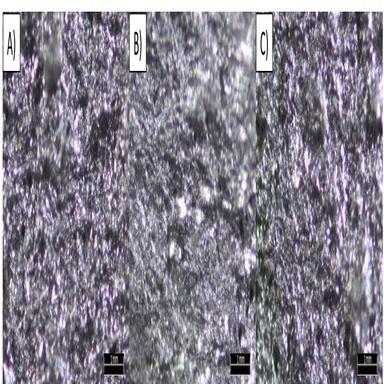
Fractography of the CT specimens A) 0◦, B) 45◦ and C) 90◦.